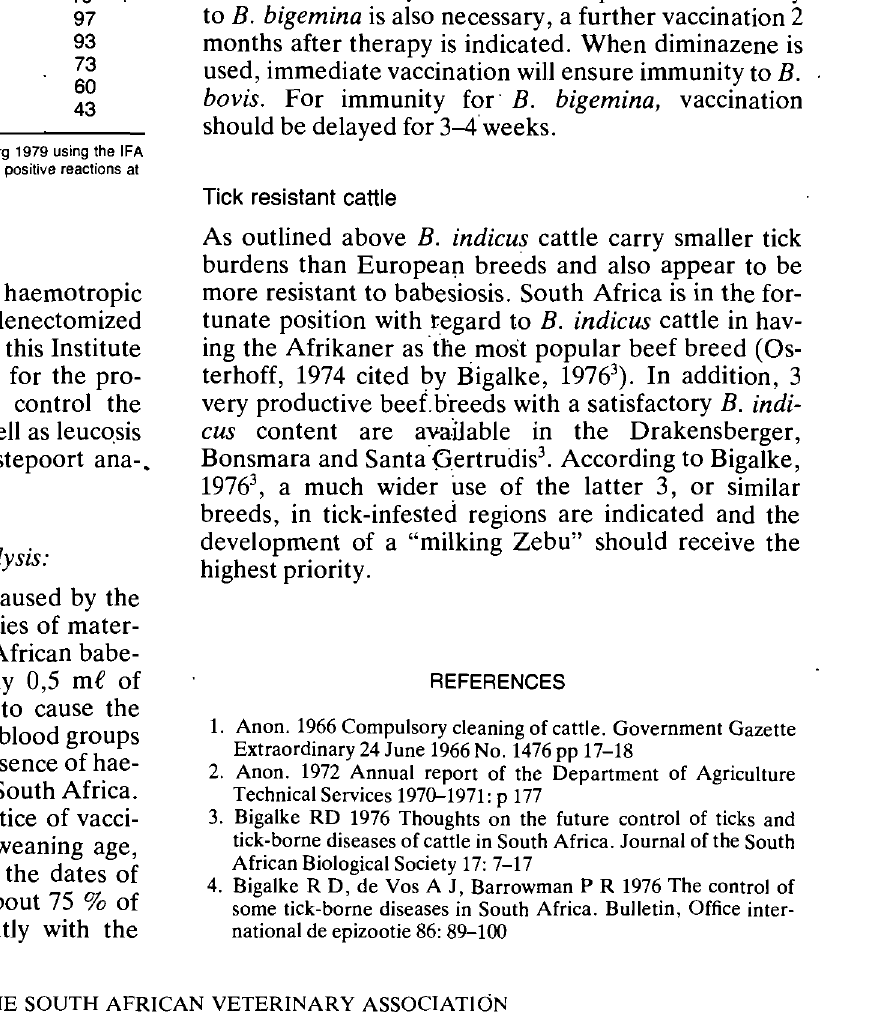
• Survey conducted on Northern Farm, Ciiy Council of Johannesburg 1979 using the IFA technique. All animals were vaccinated at 4-5 months of age and positive reactions at serum dilutions of 1 :40 were taken as